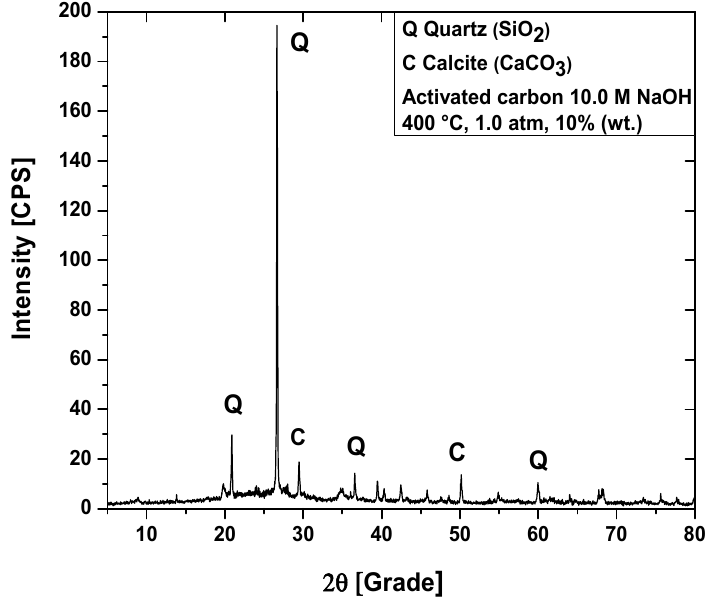
Figure 12. XRD of activated carbon pellets impregnated with 10.0 M NaOH after the upgrading of residual fat pyrolysis vapors at 400 °C, 1.0 atmosphere, 10.0% (wt.) activated carbon pellets impregnated with 10.0 M NaOH, using a catalyst fixed-bed reactor, in a semi-pilot scale two-stage reactor of 2.0 L.